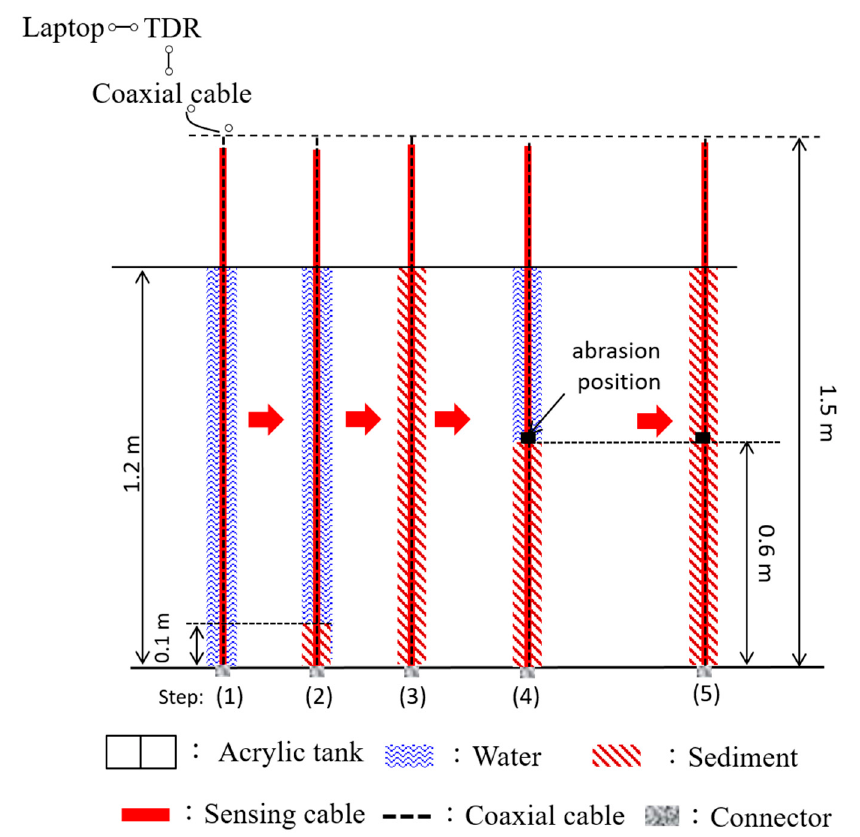
ff ect of coating